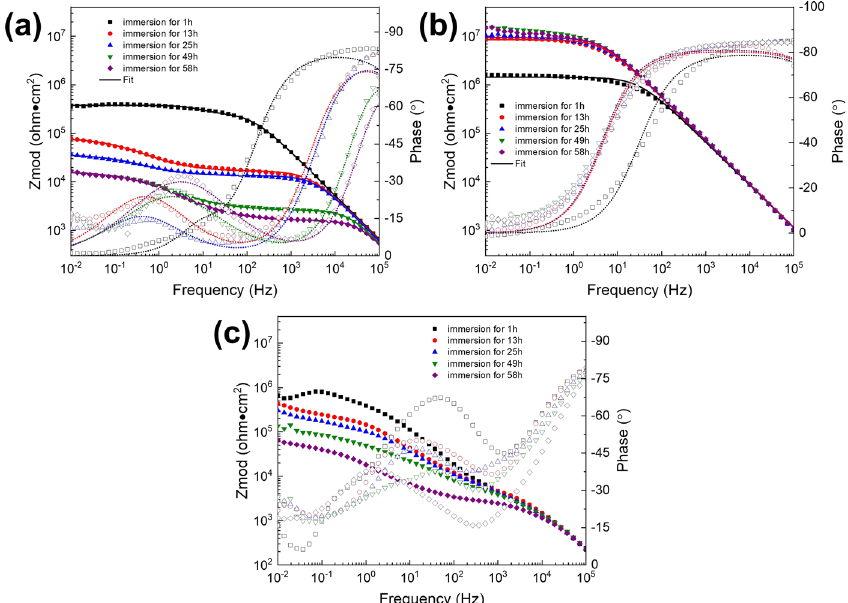
Fig. 7 EIS measurements in 100 mM NaCl. Three coated samples, including a Fiber-PVB, b Ce-Fiber-PVB, and c PVB, were corroded in 100 mM